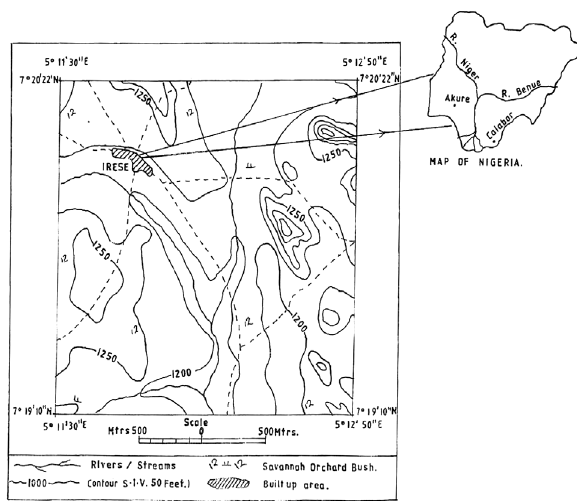
Figure 1. Topographical map of Irese area (Akure N.W. Sheet